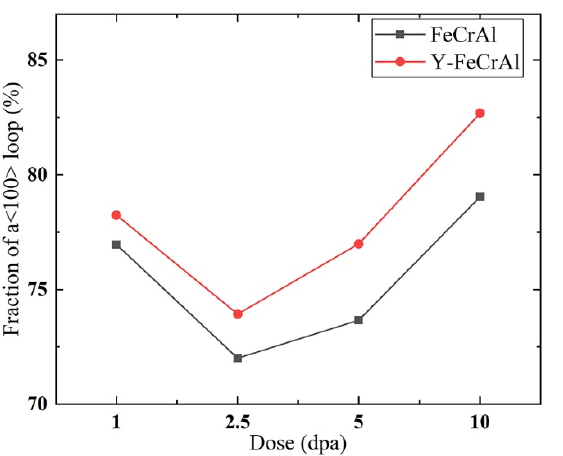
Figure 8. Proportion of a<100> dislocation loops in FeCrAl and Y- FeCrAl alloys at different doses.